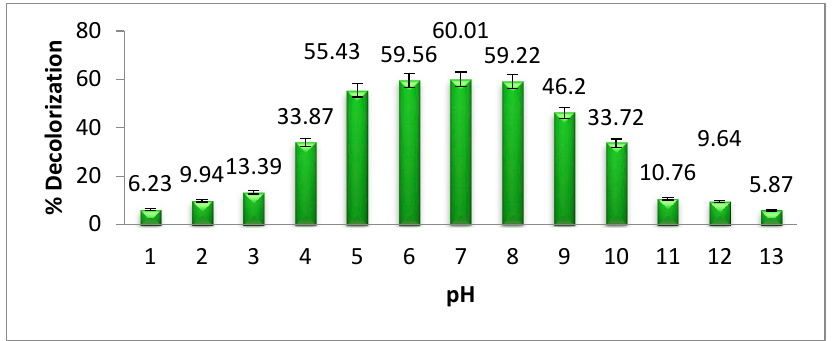
Figure 4. Effect of pH on methyl orange degradation.